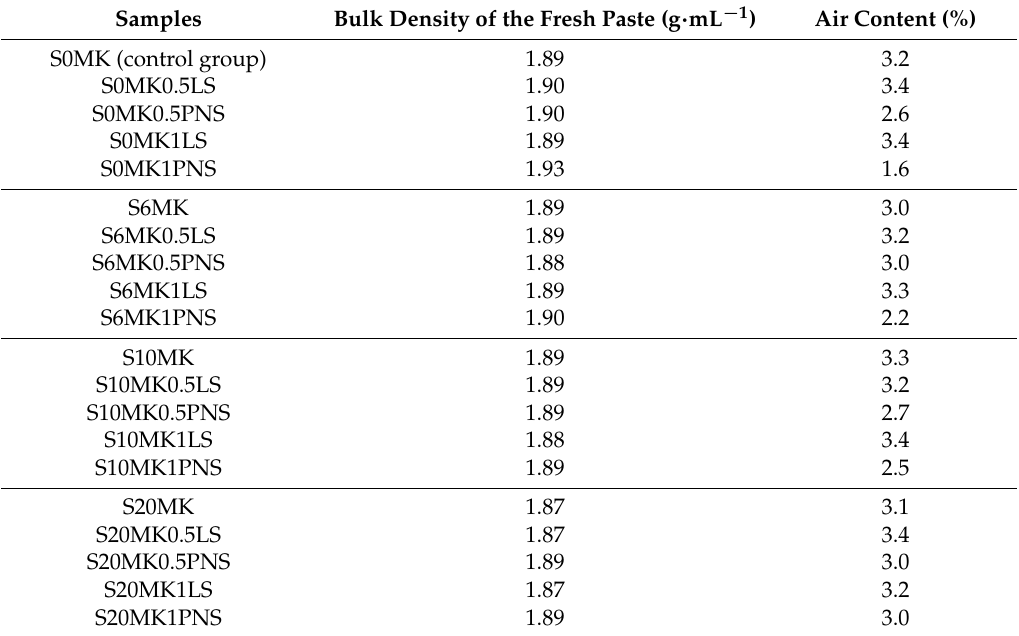
Table 2. Bulk density and air content of the fresh